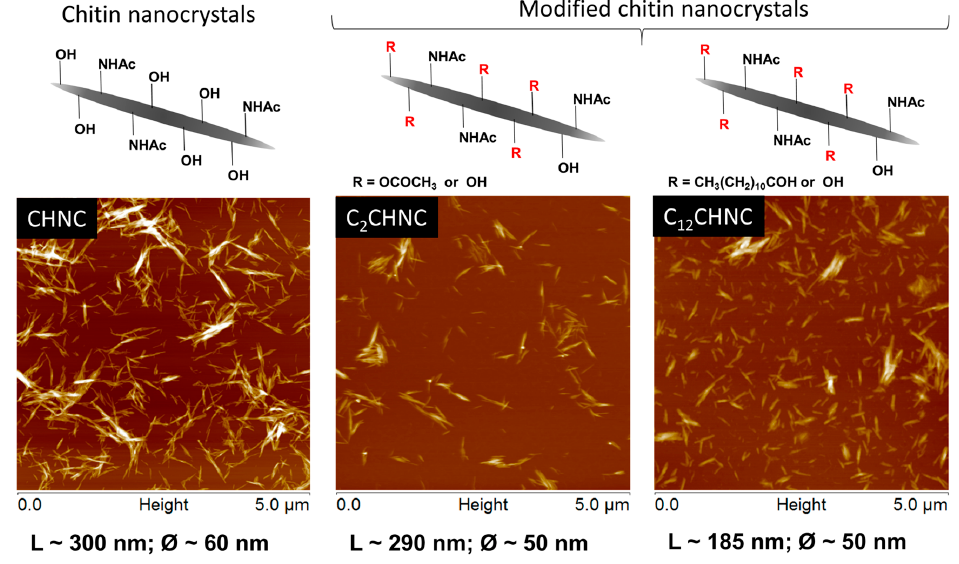
Figure 3. AFM height images of CHNC, C 2 CHNC and C 12 CHNC (L, length; and Ø, width).